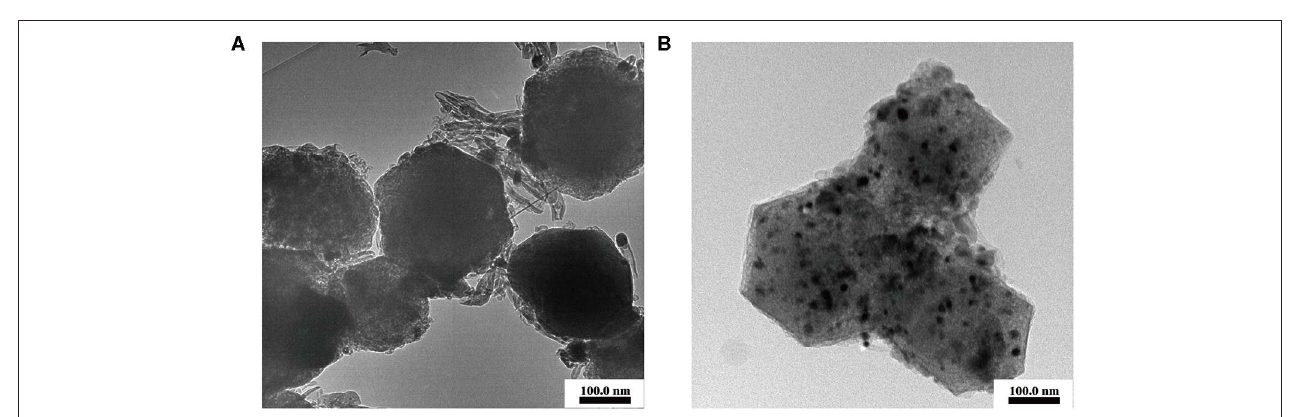
FIGURE 2 | TEM images of (A) the S-Co-N/C-I and (B) S-Co-N/C-II.